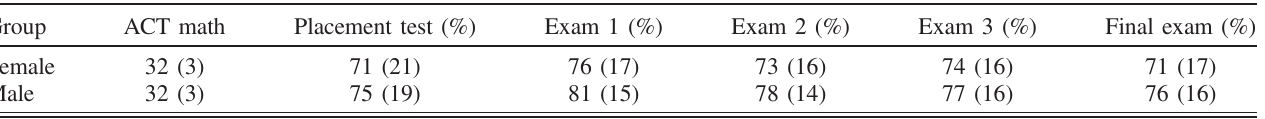
TABLE XV. Mean test scores by gender. ACT Math scores are reported as raw scores, whereas the remaining exam scores are reported as percentages. Standard deviations are included in